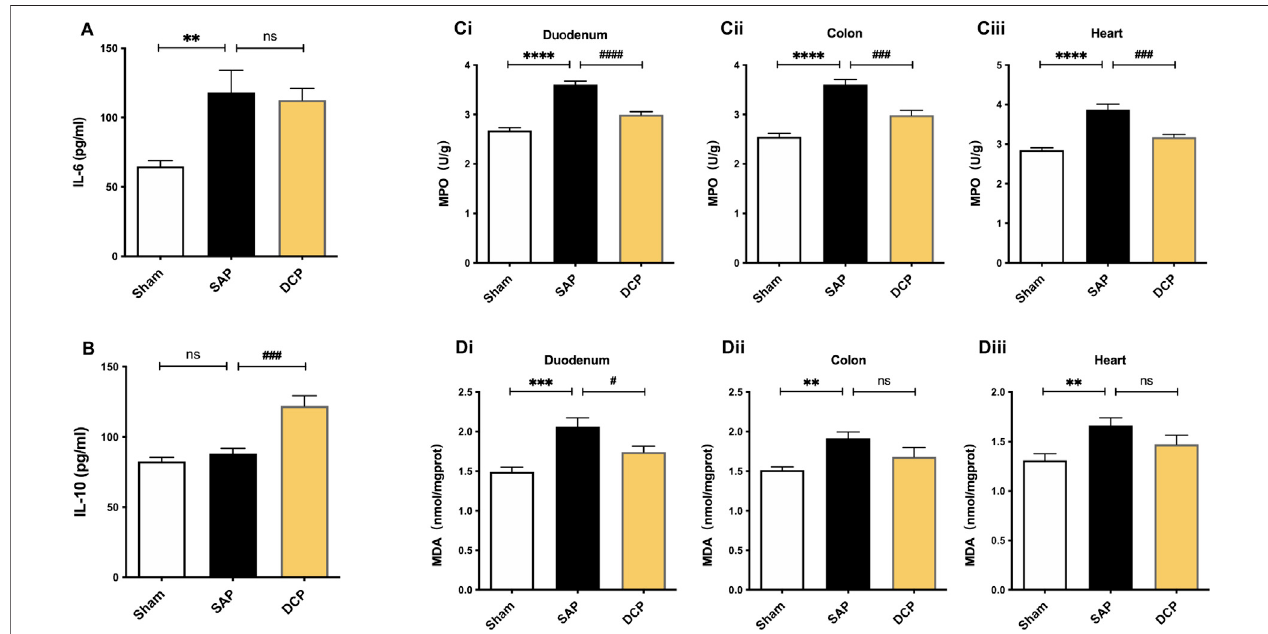
FIGURE4| DCPinhibited in fl ammatoryresponsesand oxidativestressinintestinaland cardiac tissues ofratswithSAP. (A) Serum IL-6levels ofratsinsham, SAP and DCPgroup; (B) Serum IL-10levelsofratsineachgroup; (Ci,Ciii) :TheMPOactivitywithinrats ’ organsineach group; (Di,Diii) :ThelevelsofMDAwithinrats ’ organs in each group. The results are presented as the mean ± SEM. ** p < 0.01, *** p < 0.005, **** p < 0.0001 vs. sham group, # p < 0.05, ### p < 0.005, #### p < 0.0001 vs. SAP group; ns, p > 0.05. sham: sham operation group; SAP: Sever acute pancreatitis group; DCP: Dao-Chi powder treatment